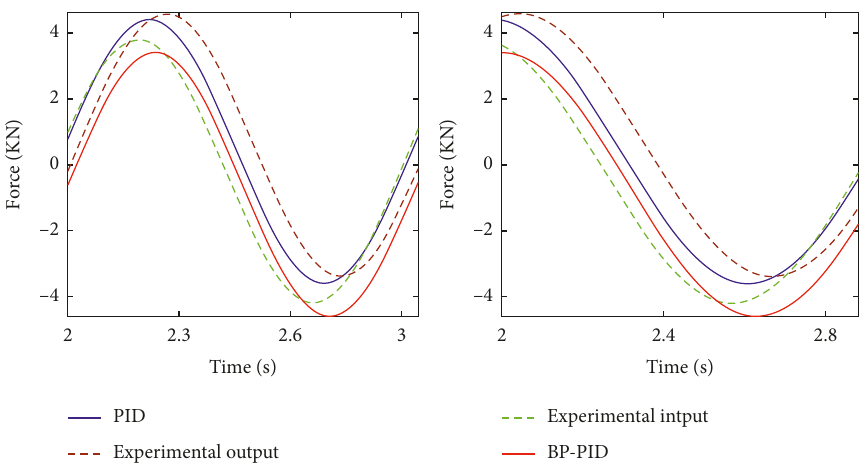
Figure 4: Experimental diagram of sine signal ( M 1).